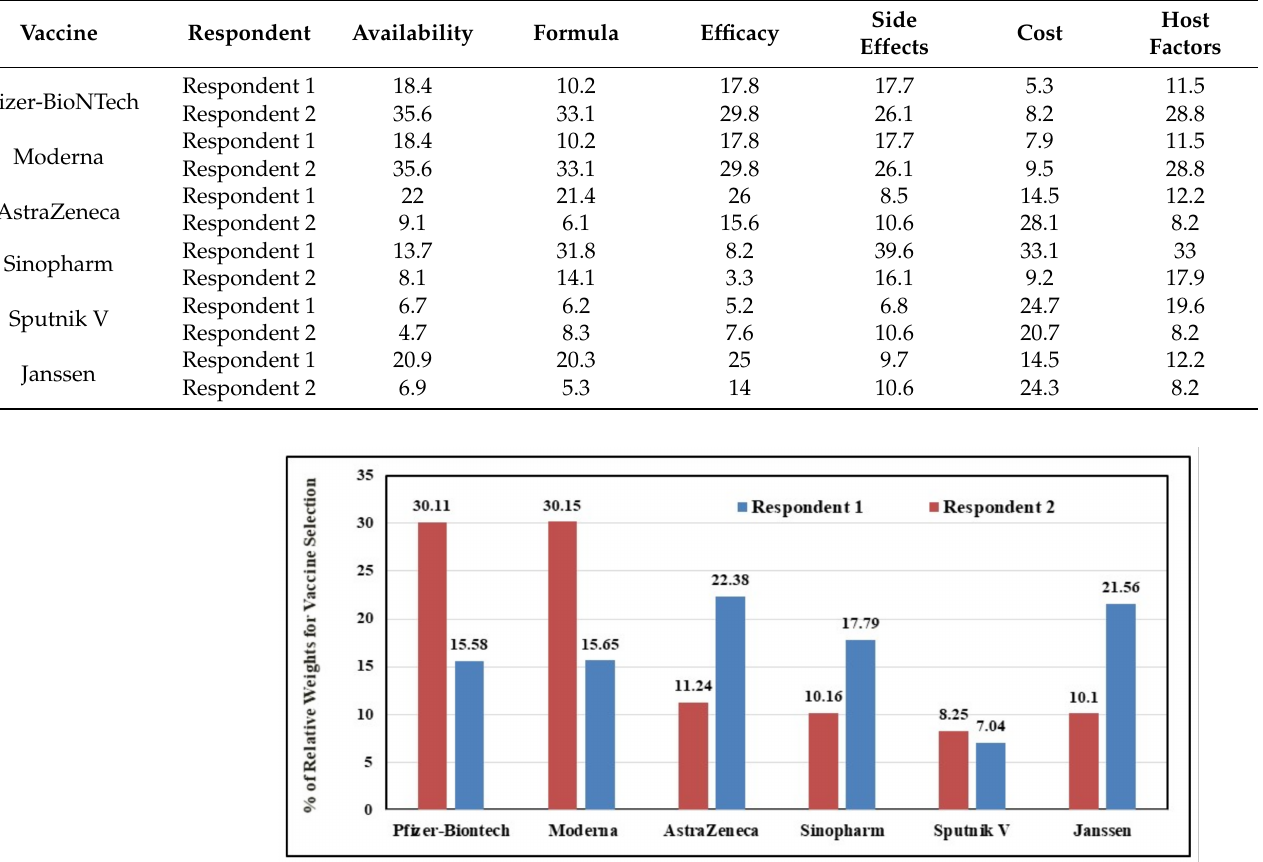
Table 4. Relative weights of vaccines based on the six comparison criteria.